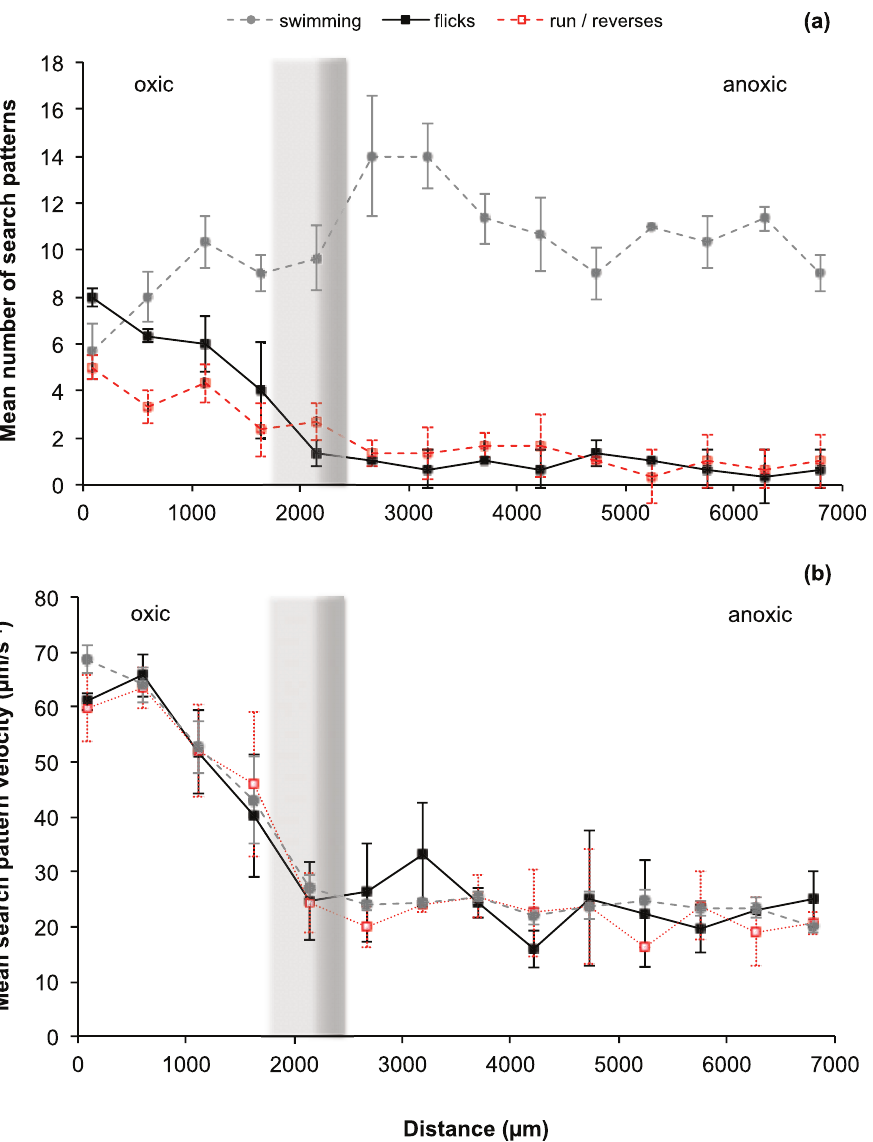
Figure 3. Vibriocoralliilyticus search patterns along an oxygen gradient. (a) The mean total number of search patterns seen along the transect line consisting of 40 quadrat boxes (error bars=95% CI); (b) Mean velocity ( m m s 2 1 ) of search patterns across the transect line (error bars=95% CI). The location of the grey gradient lines represents the location where the oxygen transition occurs in Fig. 1 (orange and green area).